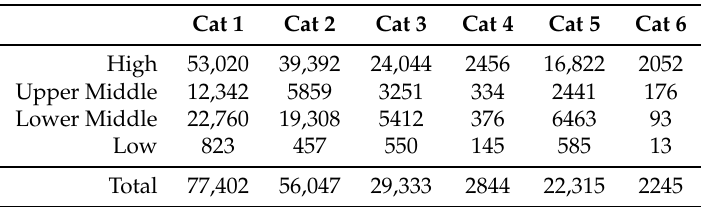
Table 6. The number of papers in each of the Frascati Manual categories containing at least one author from a nation in a given income